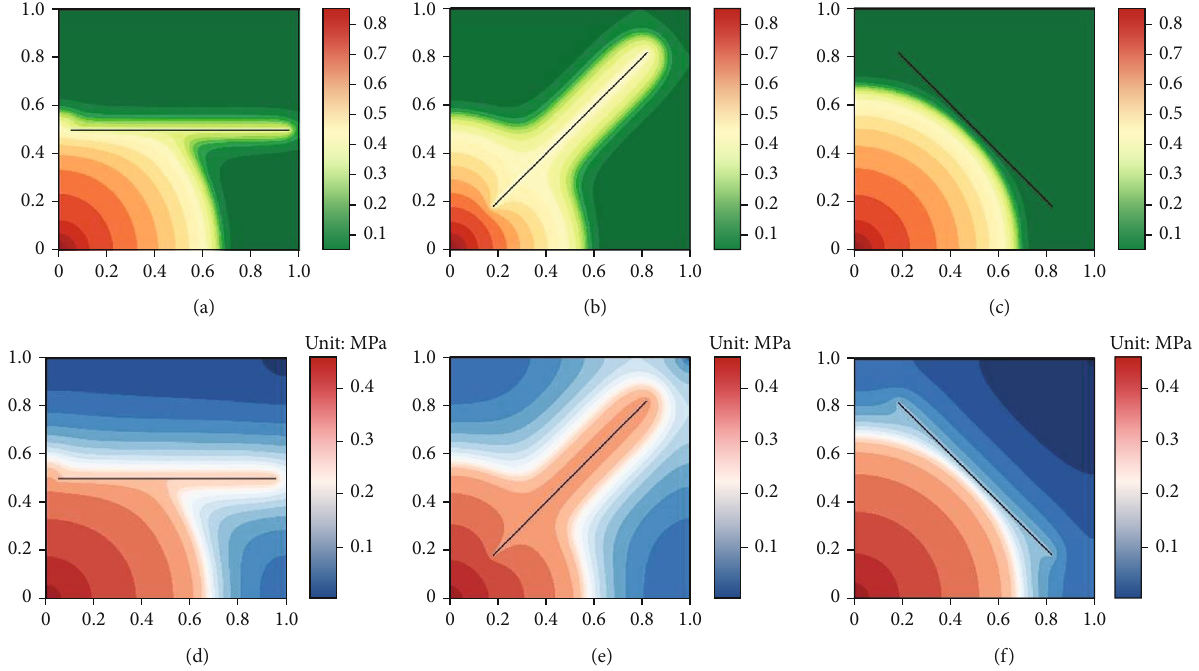
Figure 4: Spatial distribution of (a – c) saturation and (d – f) pressure after 50 days of water injection with di ff erent fracture orientations.